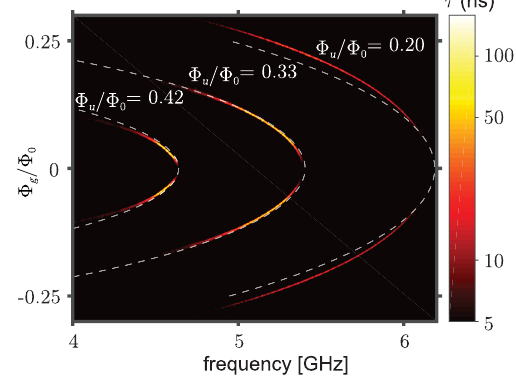
GHz.FIG. 8. Measurements of the circulator ’ s group delay τ (color, log scale) as a function of the probe frequency and a static gradiometric flux Φ applied to all four of the bridge circuits. The u duration and center frequency of the resonant delay depend on the uniform and gradiometric flux, allowing the circulator ’ s operation frequency to be tuned between 4 and 6 GHz. Dashed gray lines are predictions of Eq. (4) which use the mapping in Appendix A. To account for geometric inductance in the circuit (which is not present in the model), the dashed lines are calculated